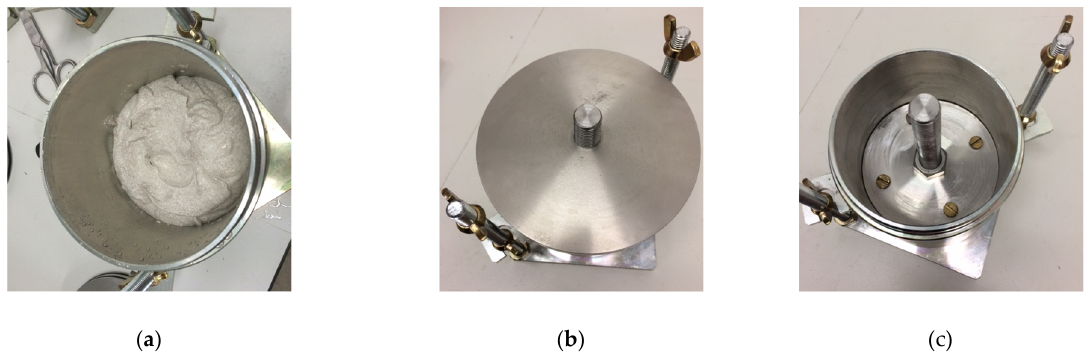
Figure 8. Soil sample preparation, ( a ) wetted soil, ( b ) compressed soil in place and kept for equilibrium, ( c ) soil sealed for testing.